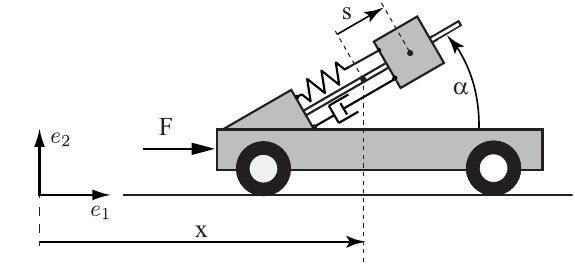
Figure 4. Mass on car